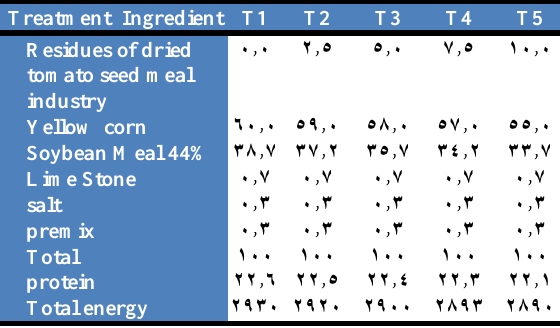
Table, 1: Diets used and their components.